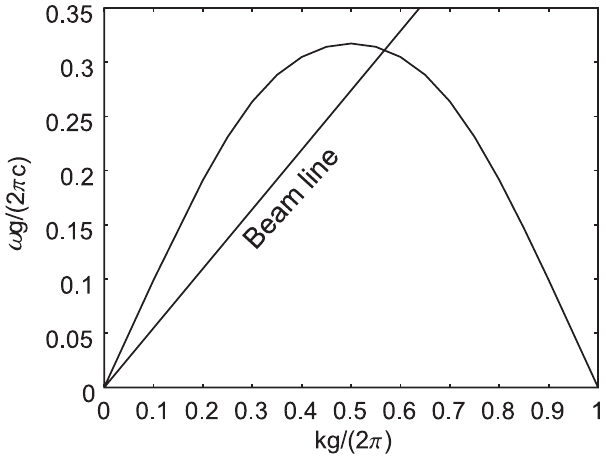
FIG. 2. Dispersion relation for the rectangular grating with